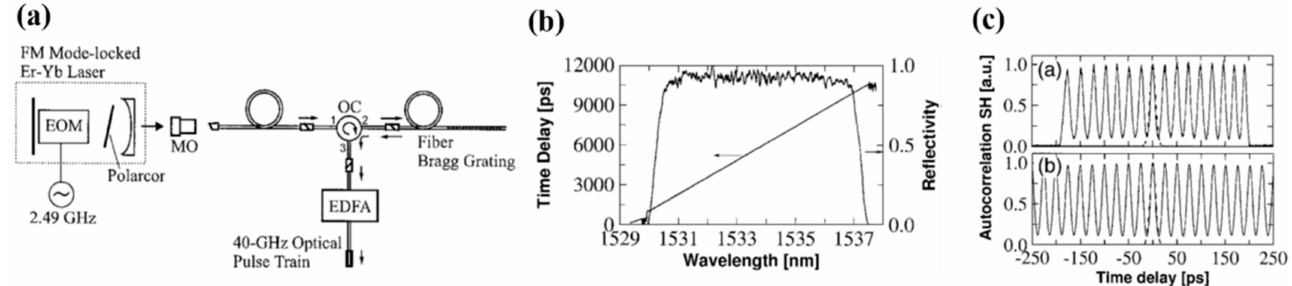
Figure 25. ( a ) Schematic of experimental layout for pulse–train multiplication. ( b ) Reflectivity and group delay spectra of the utilized linearly chirped FBG. ( c ) Autocorrelation trace of the multiplied pulse train (solid curves) and the incident pulse (dashed curve), in which there is ( a ) the measured result and ( b ) the simulation one. Adapted with permission from ref. [127]. © The Optical Society.